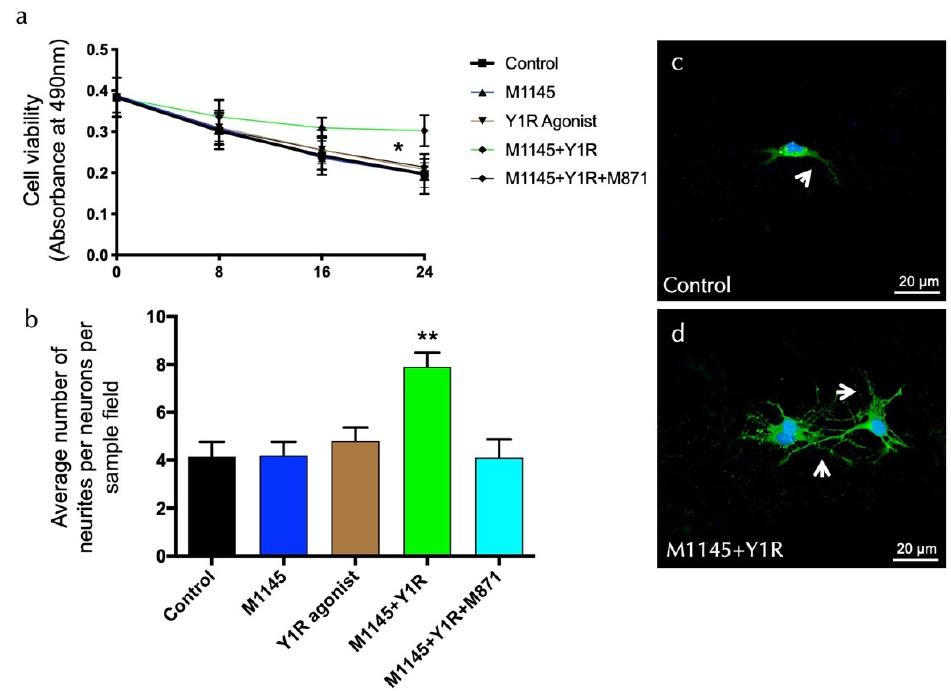
Figure 4. Evaluation of survival and neurite outgrowth on hippocampal neuronal cells. ( a ) Cell viability was determined by the MTS assay (CellTiter 96A Aqueous One Solution Cell Proliferation Assay (Promega)) with hippocampal neurons after treatment with the galanin receptor 2 agonist (M1145, 100 nM) and Y1R receptor agonist (100 nM), either alone or in combination with or without the GAL 2 receptor antagonist (M871, 1 μ M). Cells (20,000 per well) were seeded, and after seven days, the cells were incubated for 0, 8, 16, and 24 h in triplicates with the different groups. Blanks (medium only plus CellTiter 96A Aqueous One Solution Reagent) were subtracted from the value measured for each well incubated with the groups. M1145 and Y1R agonists’ incubation signifi- cantly increased neuronal survival in the dorsal DG. This effect was blocked by treatment with the GALR2 antagonist M871. * p < 0.05, 24 h after M1145 and Y1R agonist co-stimulation compared with every group according to Student’s unpaired t -test statistical analysis. Statistical values are pre- sented in Supplementary Table S1. ( b – d ) GALR2 and Y1R agonists’ modulation of neurites’ out- growth. Primary hippocampal neurons were treated for 24 h without (control) or with M1145 (100 nM) and/or Y1R agonists (100 nM) with or without the GAL 2 receptor antagonist (M871, 1 μ M). The numbers of neurites per cell were determined after immunofluorescent labeling of neurons and neuronal nuclei (Pan Neuronal Marker (ABN2300)/neuronal nuclei (DAPI)). Quantification is shown in Figure 4b, where the data are presented as mean ± SEM. The combined group is signifi- cantly different from the rest of the groups (** p < 0.01 vs. the rest of the groups according to one- way ANOVA followed by Newman–Keuls post-hoc test). Statistical values are presented in Supple- mentary Table S1. Representative microphotographs of the significant increase in the number of neurites in the hippocampal cells after M1145 and Y1R agonist treatment ( d ) compared with the control group ( c ). The cells in green are hippocampal neuron-positive using confocal laser micros- copy. White arrows point to neurite extensions. The nuclei are counterstained in blue by DAPI. Ab- breviations: Control = Culture medium, M1145 = galanin 2 receptor agonist (100 nM), Y1R agonist =